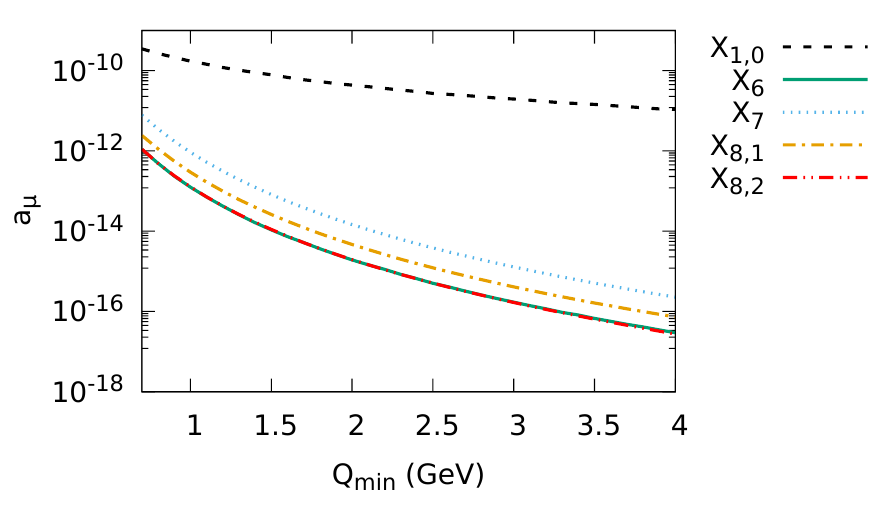
Figure 10 . Numerical contributions from the X 6 8 pieces in absolute value using the inputs from (cid:0) table 1. Even when they are not suppressed by the quark mass size, they are found to be small compared with the massless quark loop contribution.